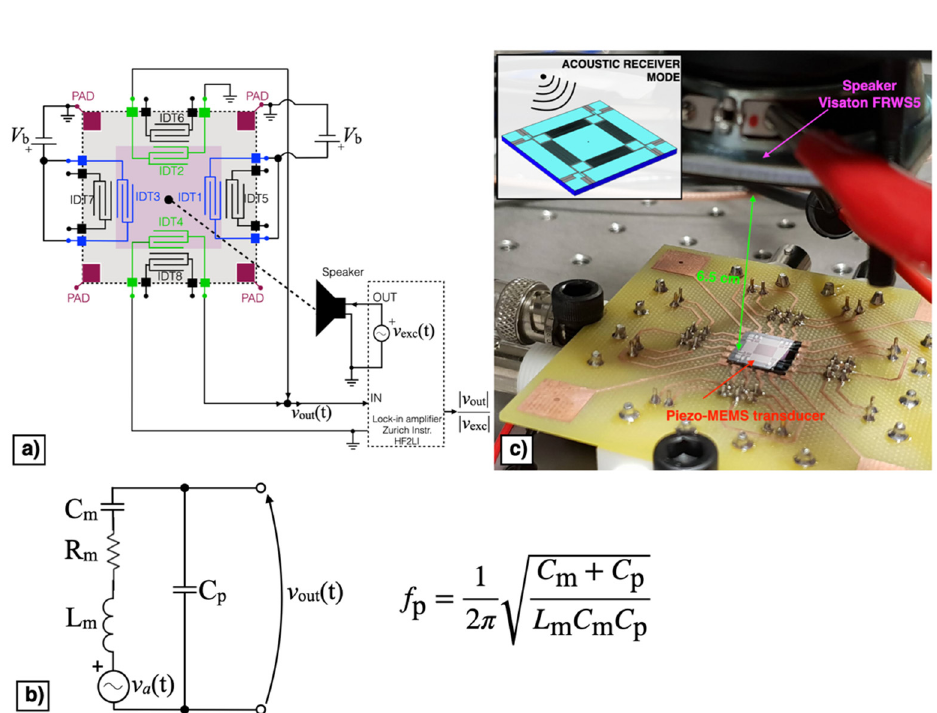
Figure 11. Block diagram ( a ), equivalent Butterworth–Van Dyke (BVD) model ( b ) and experimental set-up ( c ) of the piezoelectric MEMS device in acoustic receiver mode.